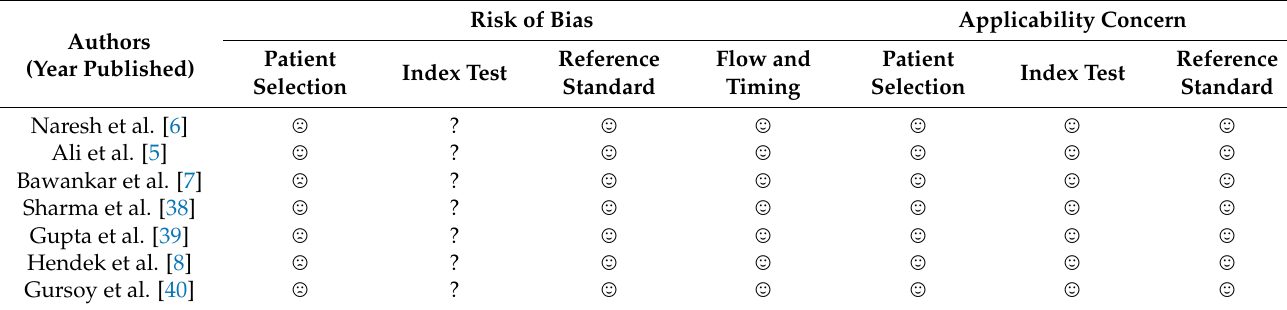
Table 2. QUADAS-2 risk of bias